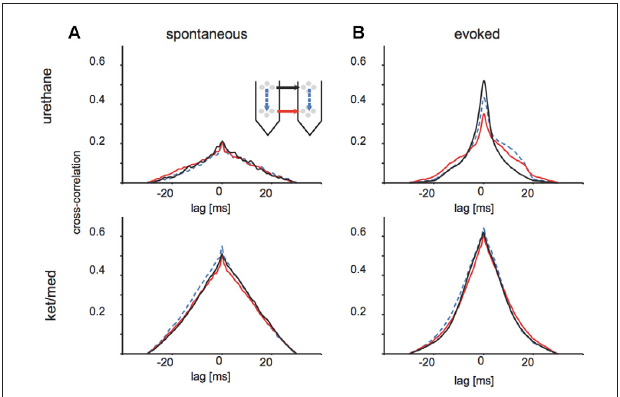
FIGURE 5 | Cross-correlation of multi-unit activity across different sites of the probes. (A) Cross-correlations of spontaneously appearing events (multi-unit activity) under urethane (upper panel) and ketamine/medetomidine (lower panel) anesthesia. Line styles indicate geometry of the depicted pairwise comparision. Black: across shanks, superficial tetrodes; red: across shanks, deeper tetrodes; blue dotted: within shank, across tetrodes. (B) Same quantification as (A) but for evoked activity within a 50 ms window of sound